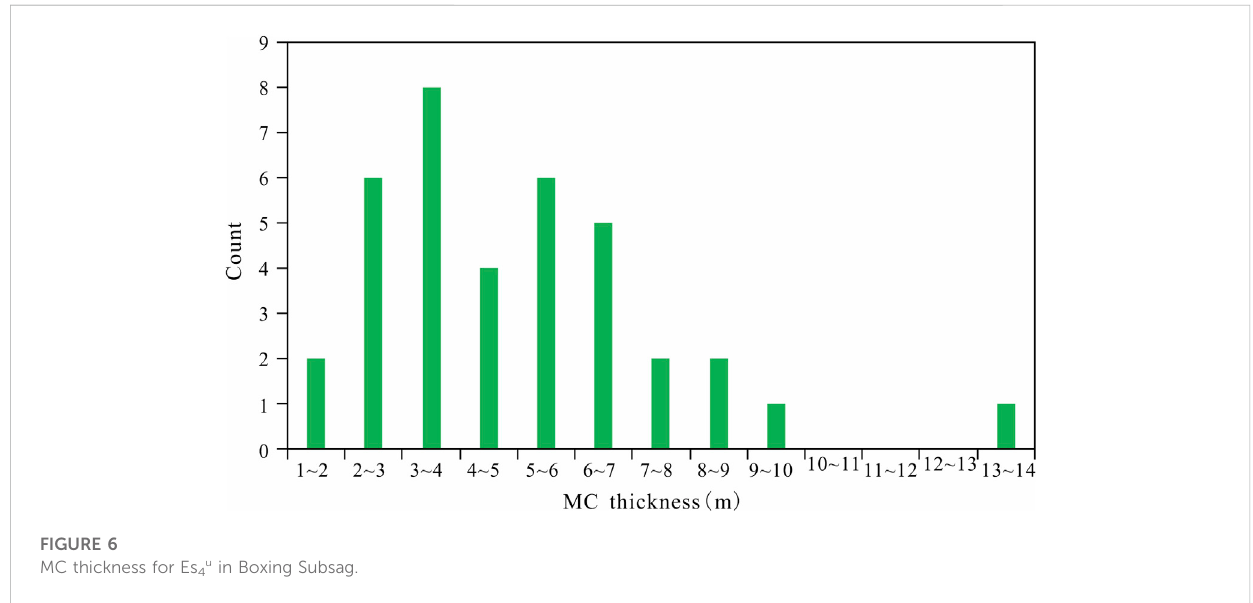
FIGURE 6 MC thickness for Es 4 u in Boxing Subsag.